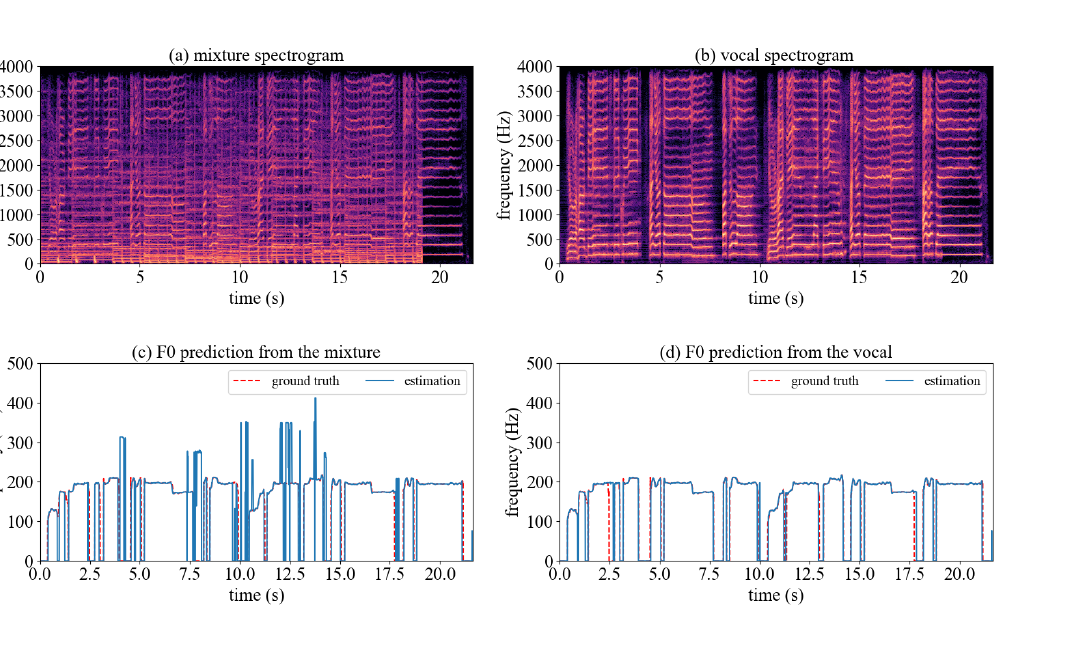
Figure 10. Good example: “pop4.wav” from ADC2004 dataset.